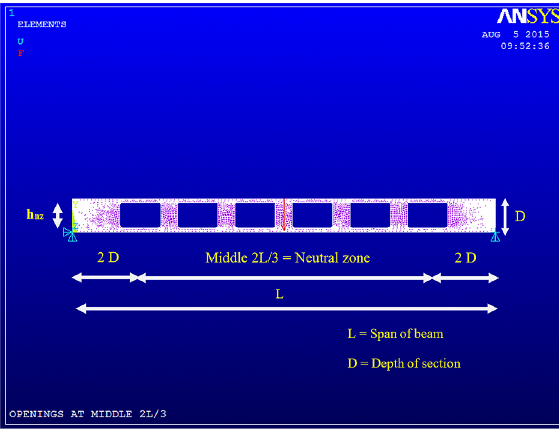
Fig. 18. Neutral zone in steel beam with web